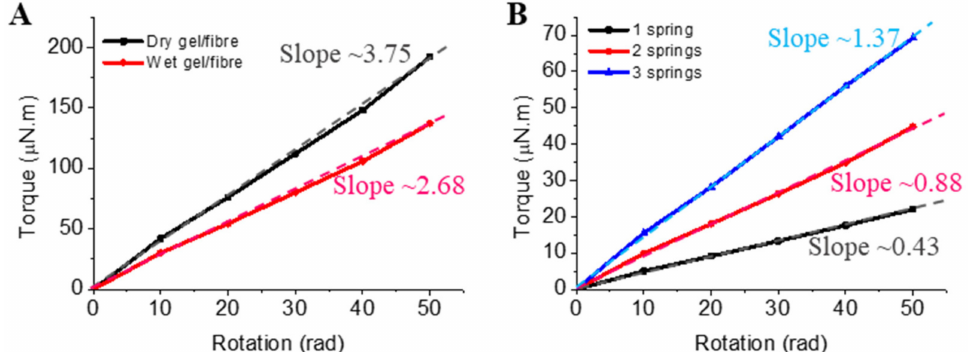
Figure 4. Torque-rotation curves: ( A ) gel fibre actuator; ( B ) return springs. (The slopes of the curves define the torsional stiffness of relevant